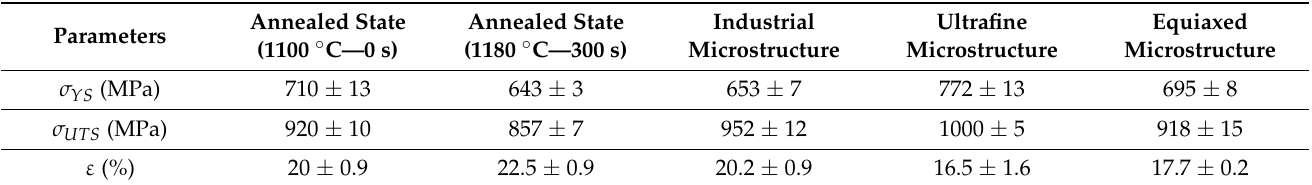
Figure 13. Microstructures of ( a ) the skin and ( b ) the core of a solution-treated sample. Ferrite grains appear in dark and austenite ones appear in light.